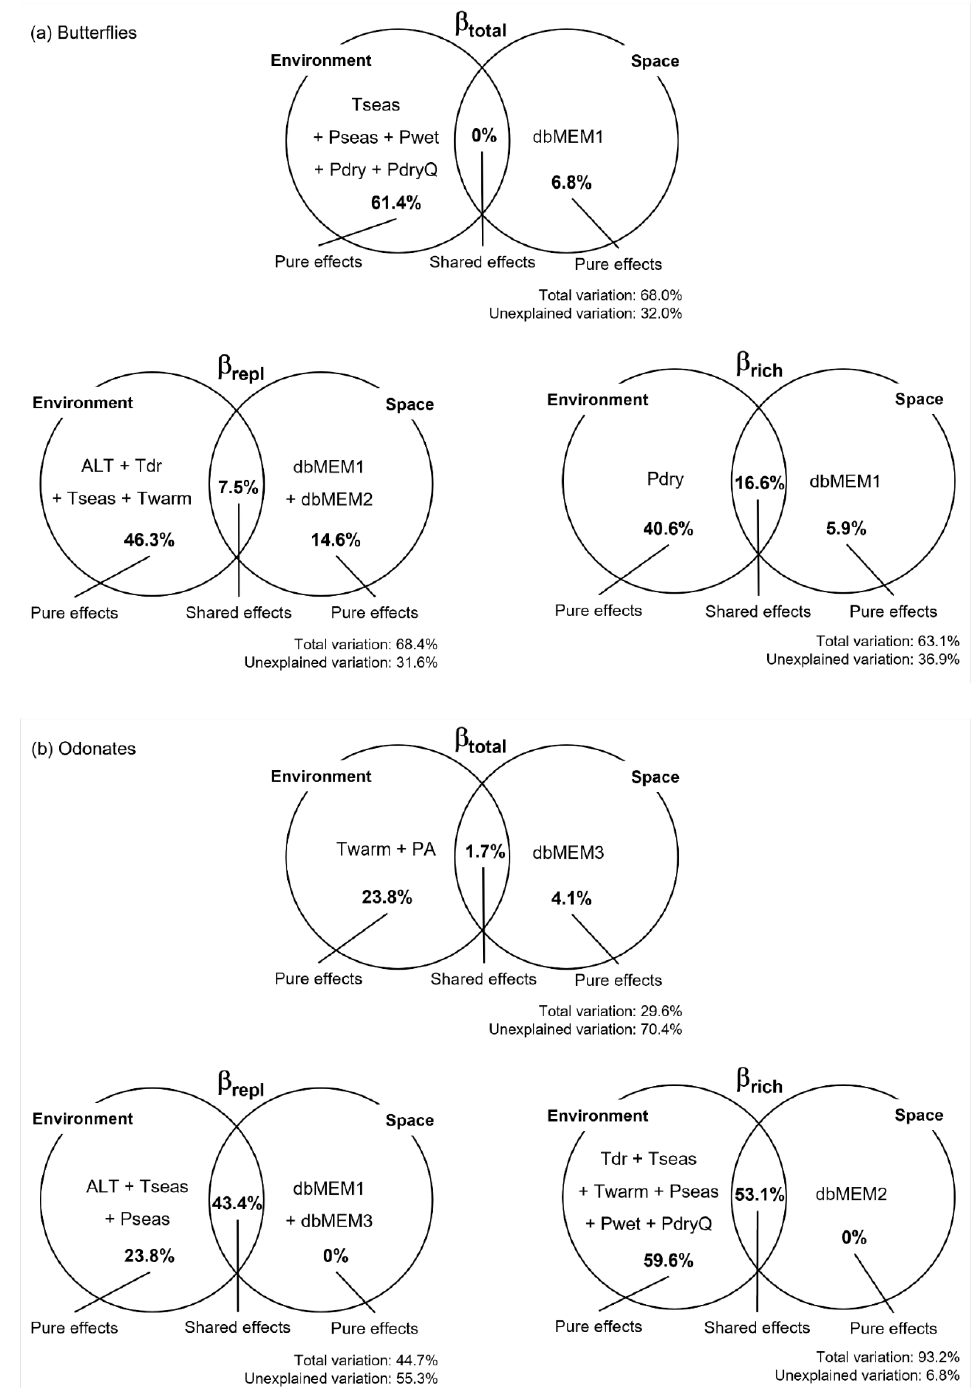
Figure 3. Variation partition for butterflies ( a ) and odonates ( b ). Venn diagrams show the variables explaining variation in β total, β repl, and β rich, as well as the percentage of variation (adjusted R2) explained by each effect. Variable names stand for: altitude (ALT), annual precipitation (PA), precipitation of the driest month (Pdry), precipitation of the driest quarter (PdryQ), precipitation seasonality (Pseas), precipitation of the wettest month (Pwet), temperature mean diurnal range (Tdr), temperature seasonality (Tseas), and maximum temperature of the warmest month (Twarm). dbMEM variables correspond to the spatial relationships among sampling sites.